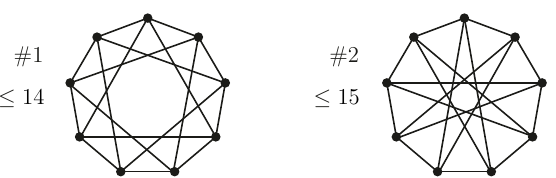
Figure 9 . Polygon diagrams of N in the O ( N )